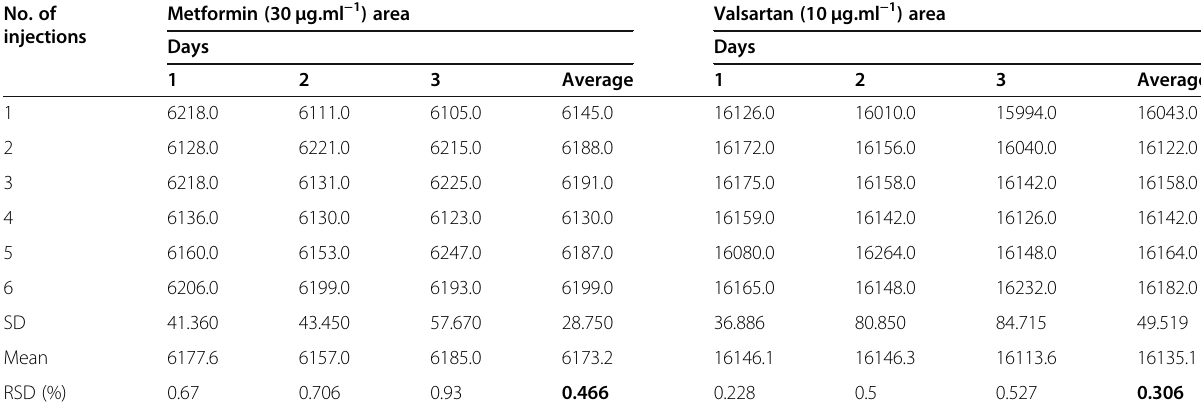
Table 5 Intermediate precision of valsartan and metformin No. of